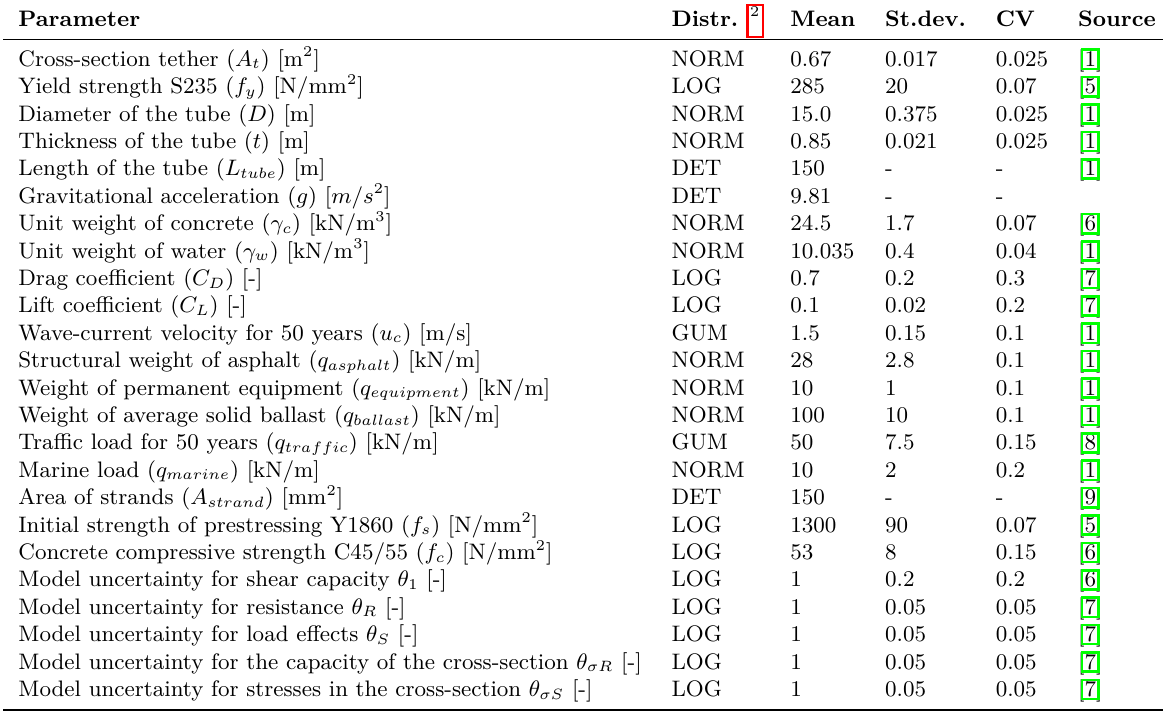
Table 1. Input parameters for reliability analysis